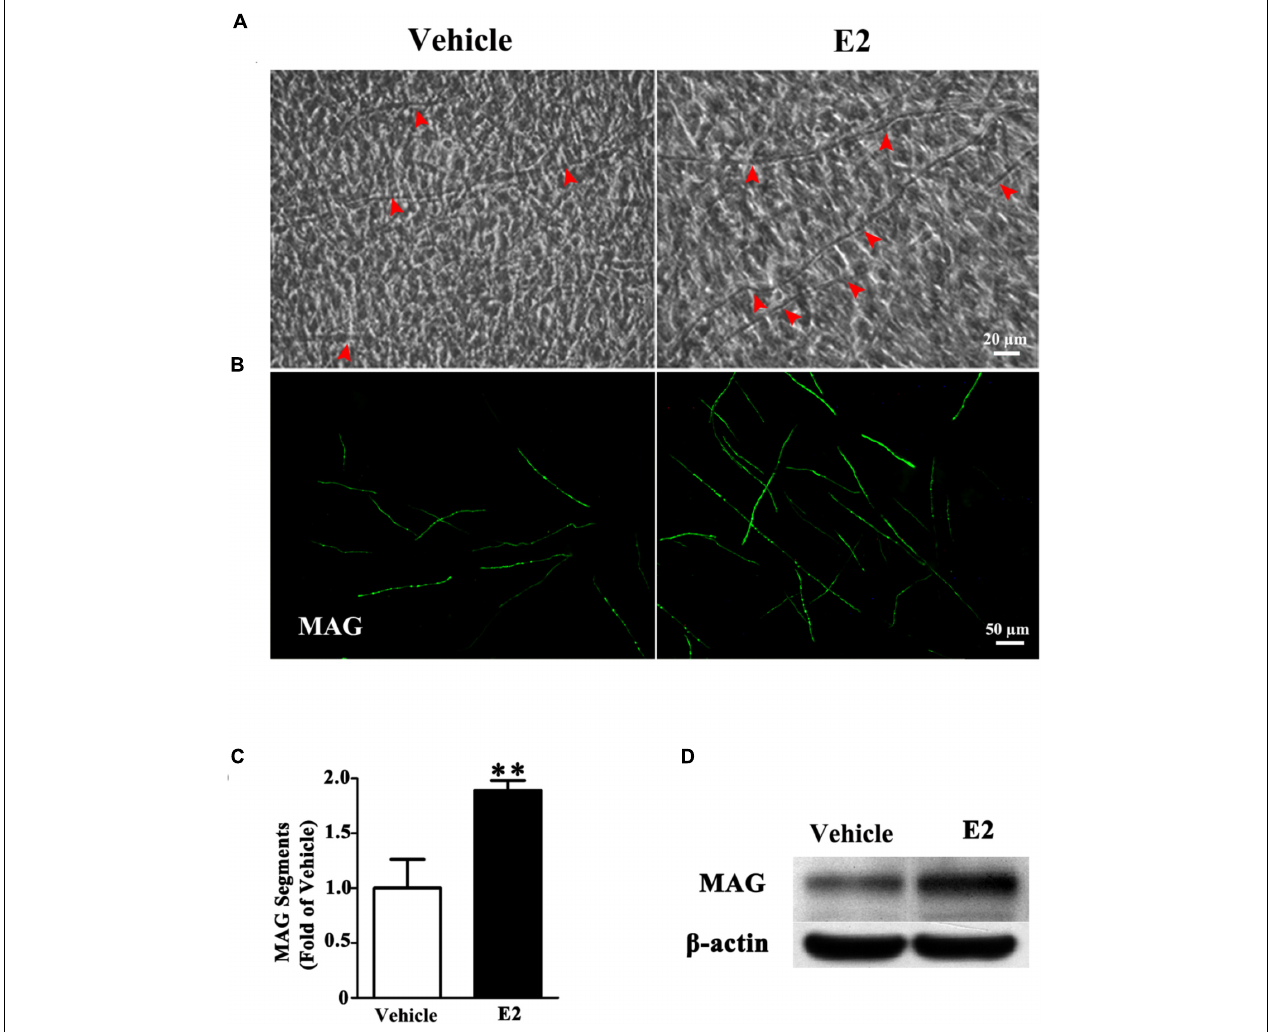
FIGURE 1 | E2 treatment accelerated myelin formation in DRG neurons co-culture with Schwann cells. (A–D) Schwann cell/DRG neuron cocultures were grown in myelin-promoting media with or without E2 and maintained for 28 days, the cocultures were photographed (A) or fixed and stained for MAG (B) , red arrow showing the myelinated axons, scale bar, 50 µ m. (C) The numbers of myelin sheaths per high-powered field were counted. The ratio of mean values for each E2 and vehicle from three representative experiments are shown. The number of myelin sheaths in the cultures treated with E2 was significantly higher than that in control cultures. ∗∗ p < 0.01, Student’s t -test, n = 3 cultures per group. All the data are mean ± SEM. (D) Western blot for the expressions of myelin proteins MAG, β -actin served as a protein loading control. The results showed the expression of MAG in cocultures with E2 treatment was higher than that without E2.